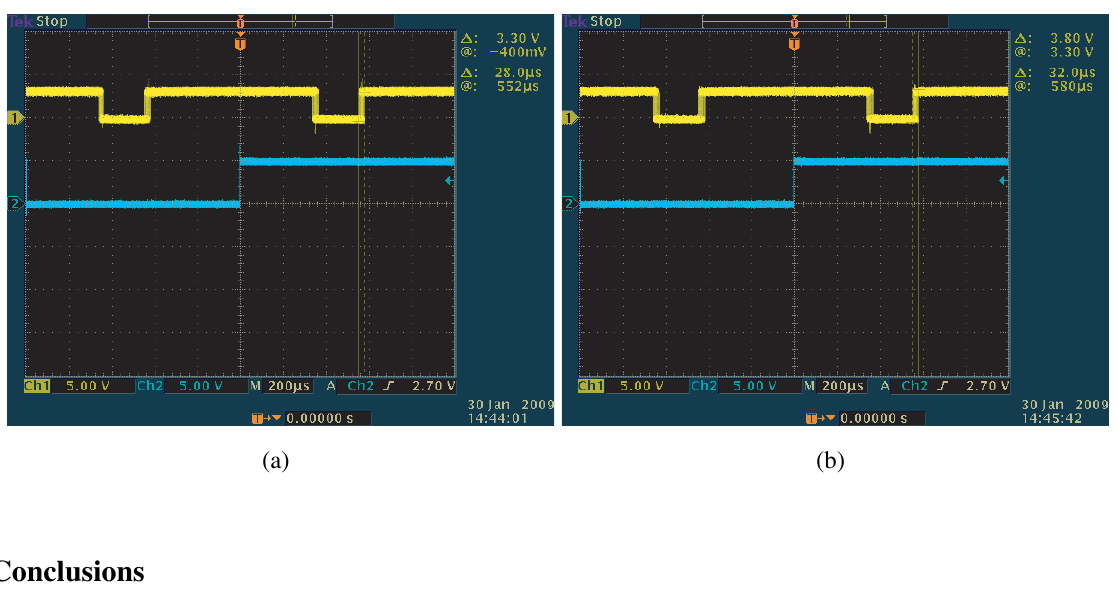
Figure 19. Jitters comparison concerning the torch illumination, (a) jitters without the incandescent torch disturbance, (b) jitters with the incandescent torch